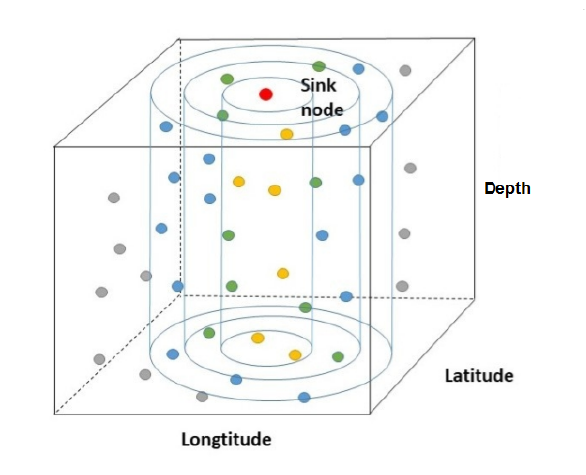
Figure 3. The layer-divided model of the 3-D